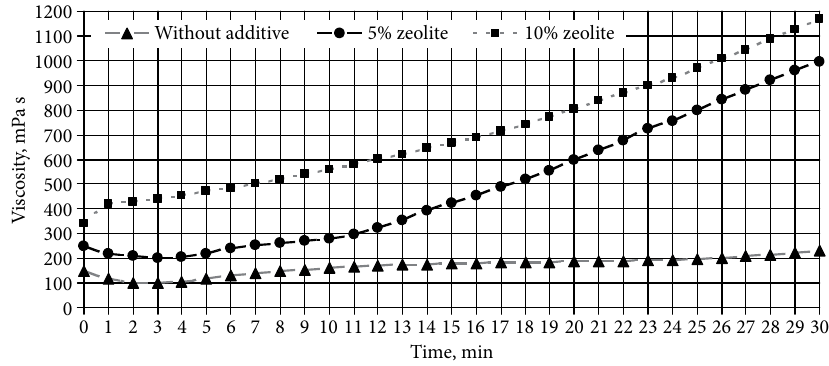
Fig. 3. The relationship between the viscosity of cement paste and time